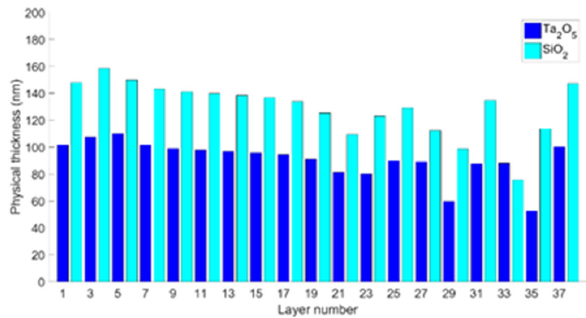
Figure 7. Layer thicknesses in the DCM in the final design.